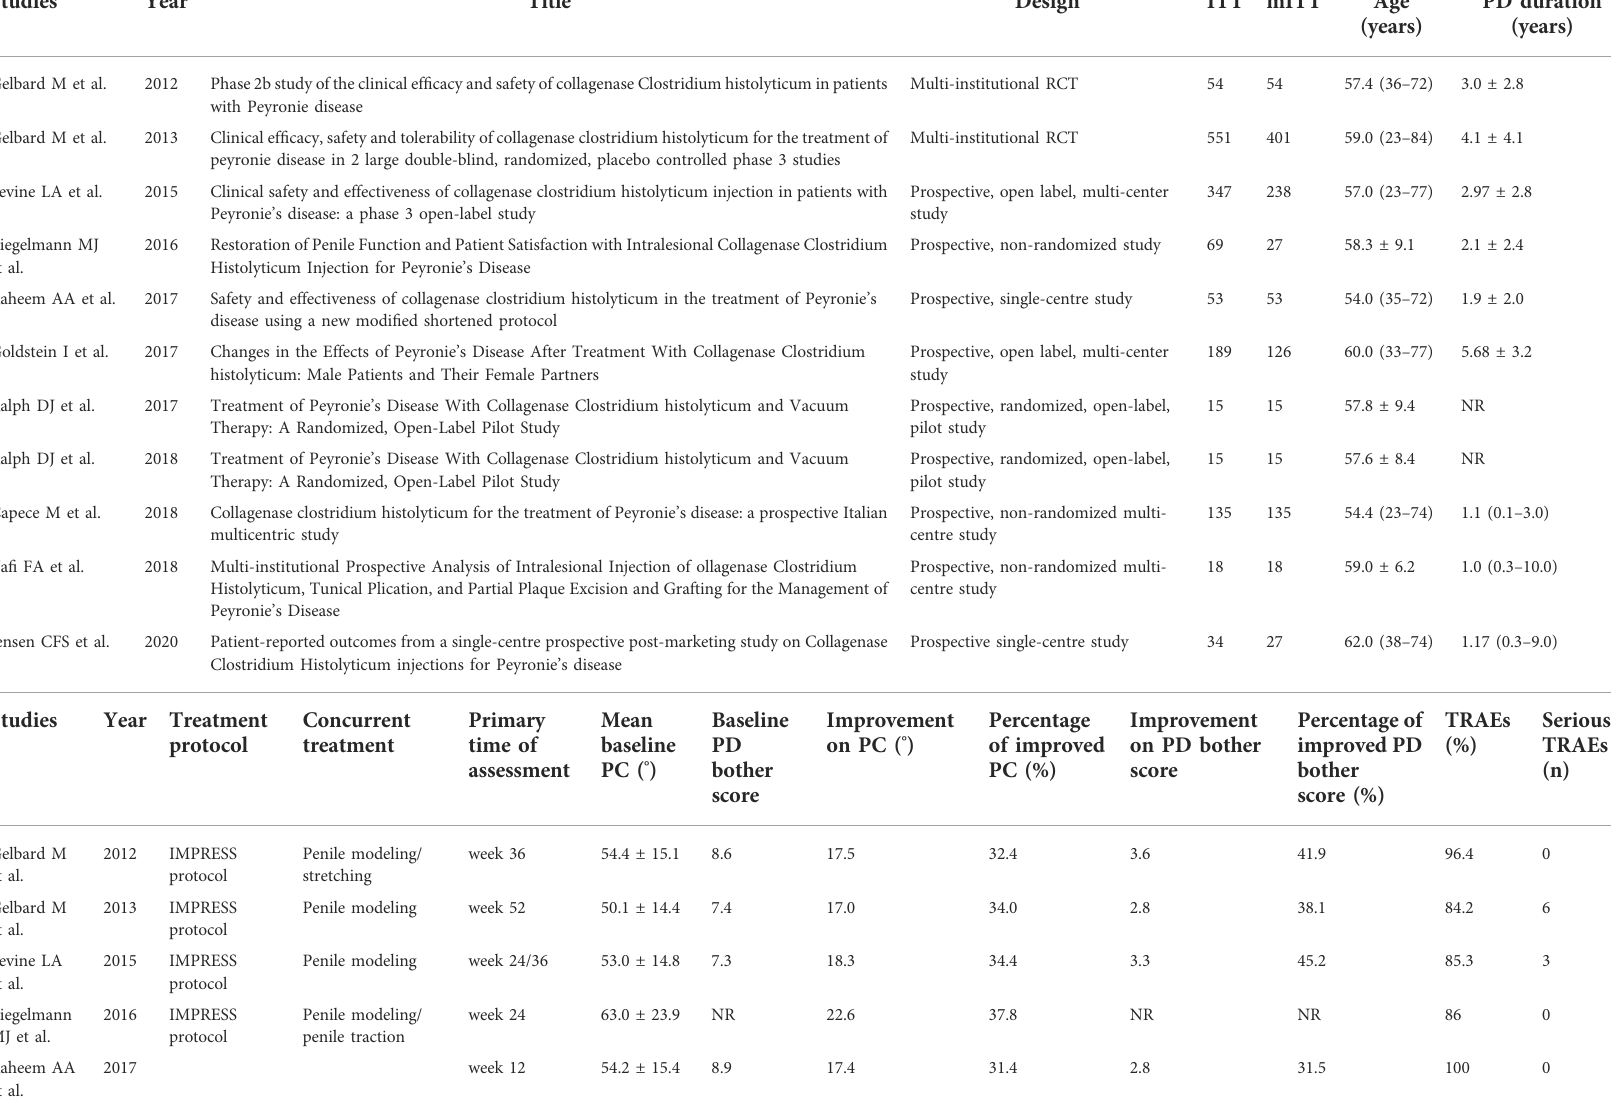
TABLE 1 Characteristics of included